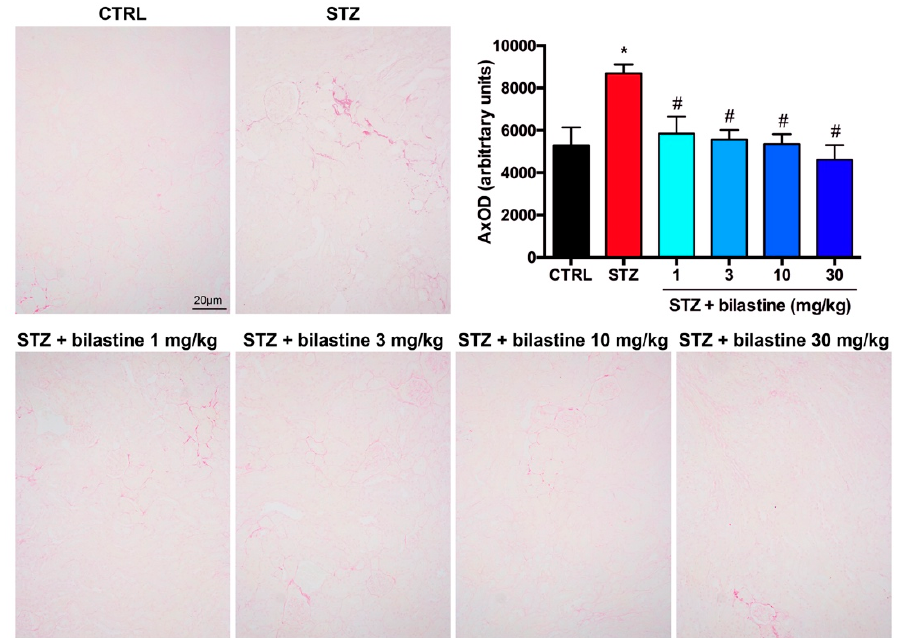
Figure 9. Effect of bilastine on tubular fibrosis. Collagen deposition in the renal interstitium evaluated by picrosirius red stating. Micrographs at 20 × magnification are representative of 10 animals / group (20 microscopic fields / specimen). The densitometric analysis is expressed as the mean ± S.E.M. ( n = 10); * p < 0.05 vs. CTRL, # p < 0.05 vs. STZ.